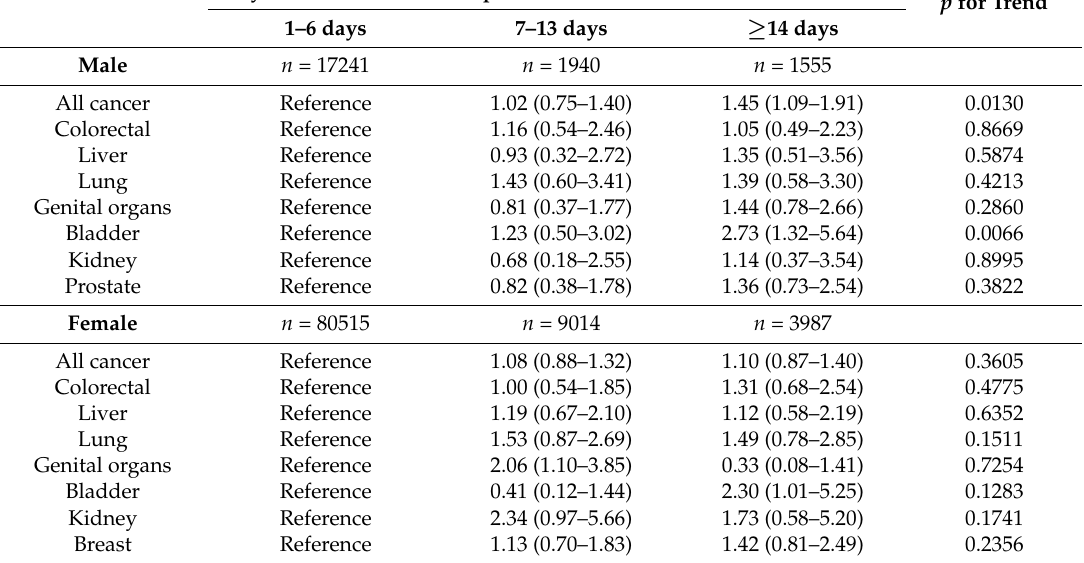
Table 6. Adjusted hazard risk † of cancer for dosage (days) trend of antibiotics prescriptions in patients with